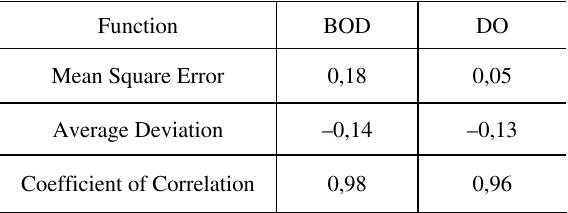
Table 4. Values of quantifying characteristics for 2 July 2002 Function Mean Square Error